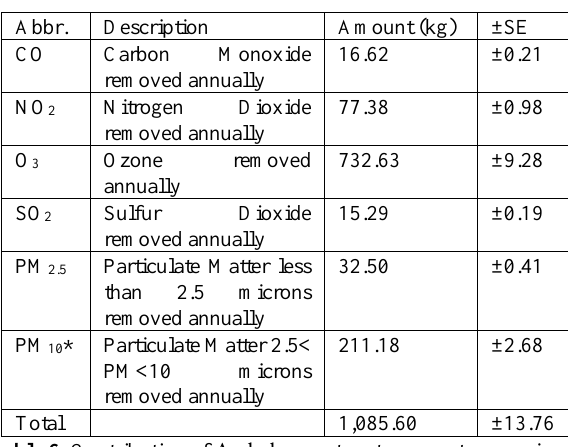
Table 6 . Contribution of Andızlı cemetery to ecosystem services The total contribution of the Andızlı cemetery to ecosystem services within the scope of reducing the effects of air pollution is approximately 1 ton per